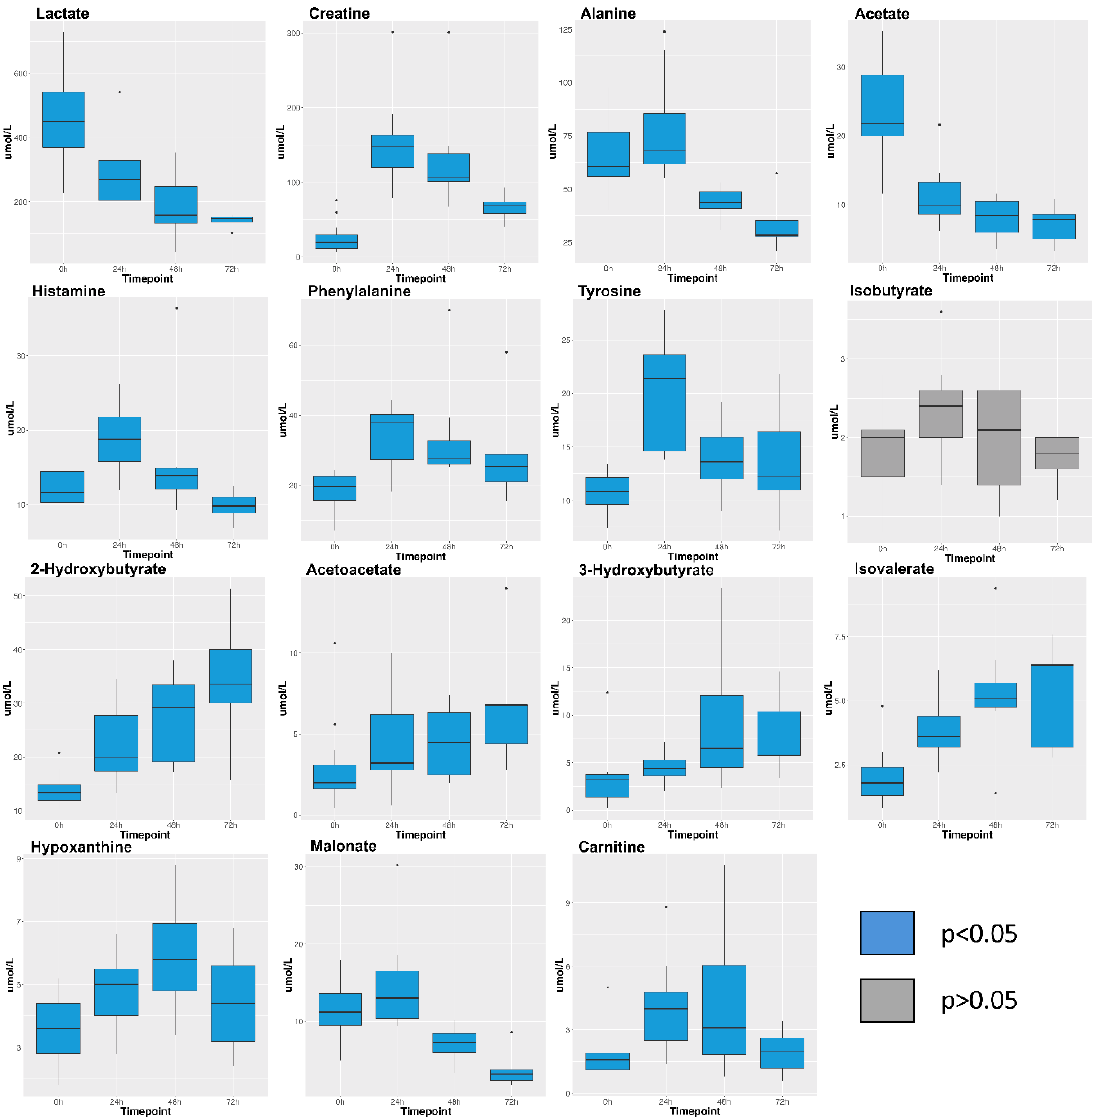
Figure 3. Box plots visualizing concentrations (micromolar) for selected metabolites. Plots show the median and interquartile range of profiled concentrations at each time point. Blue box plots indicate that metabolite concentration changed significantly during the experiment ( p < 0.05). Grey box plots indicate the concentration of the metabolite did not change significantly ( p > 0.05). Samples analysed per timepoint are: 0 h ( n = 15); 24 h ( n = 11); 48 h ( n = 8); 72 h ( n = 5). Kruskal-Wallis p-values for all metabolites can be found in Supplementary Table S2.